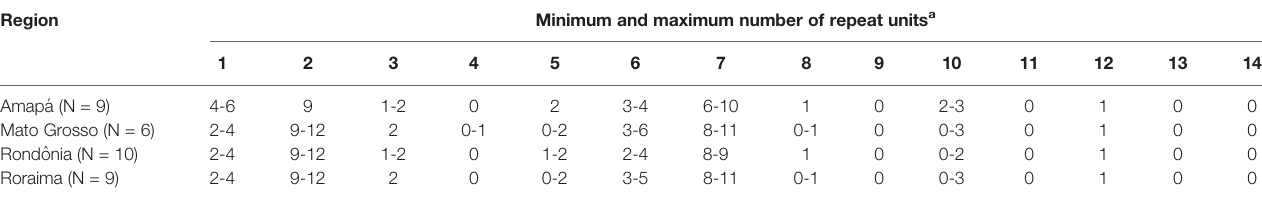
TABLE 4 | Repeat types and number of repeat units in pfhrp2 gene for 34 Plasmodium falciparum isolates from the Brazilian Amazon region. Region Minimum and maximum number of repeat units a